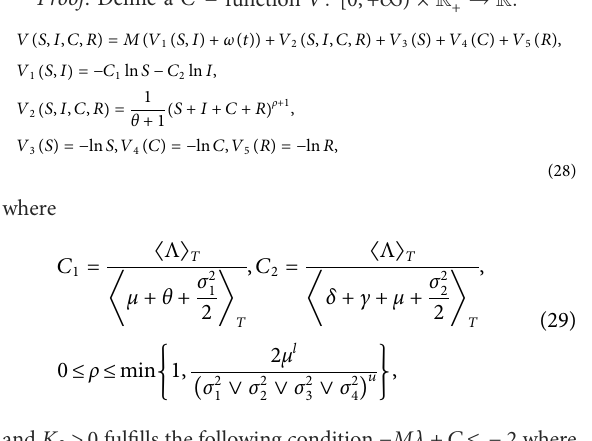
FIGURE 6 Path simulations of I(t) for the stochastic model with β 1 ( 1 ) (cid:2) 0 . 1 , β 1 ( 2 ) (cid:2) 0 . 3 , and β 1 ( 3 ) (cid:2) 0 .